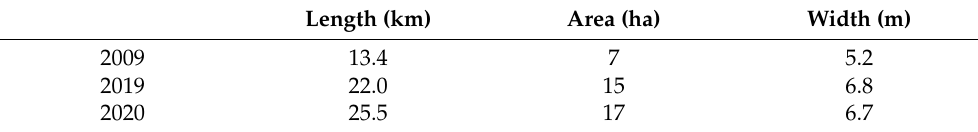
Table 8. Road changes.